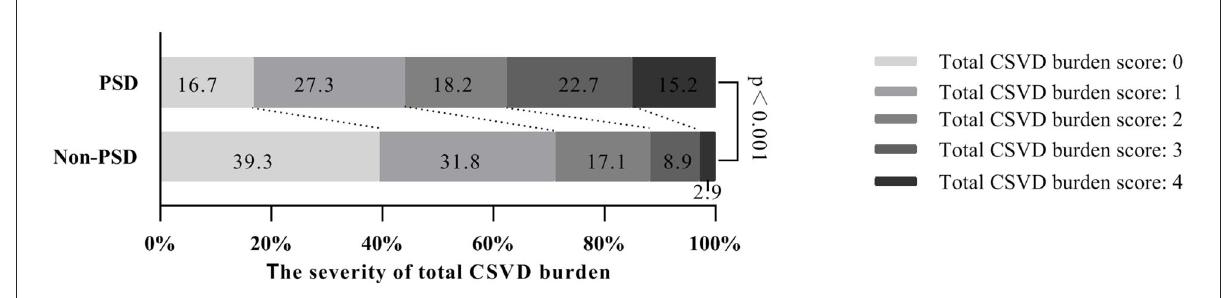
FIGURE1 Total CSVD burden score distribution between the two cohorts. CSVD, cerebral small vessel